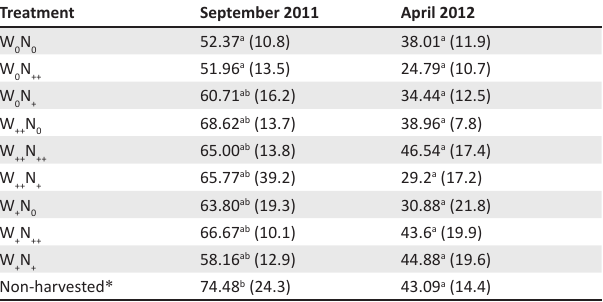
TABLE 1: Differences in total non-structural carbohydrate (mg g -1 DW) levels between September 2011 and April 2012 as a function of water and nutrient